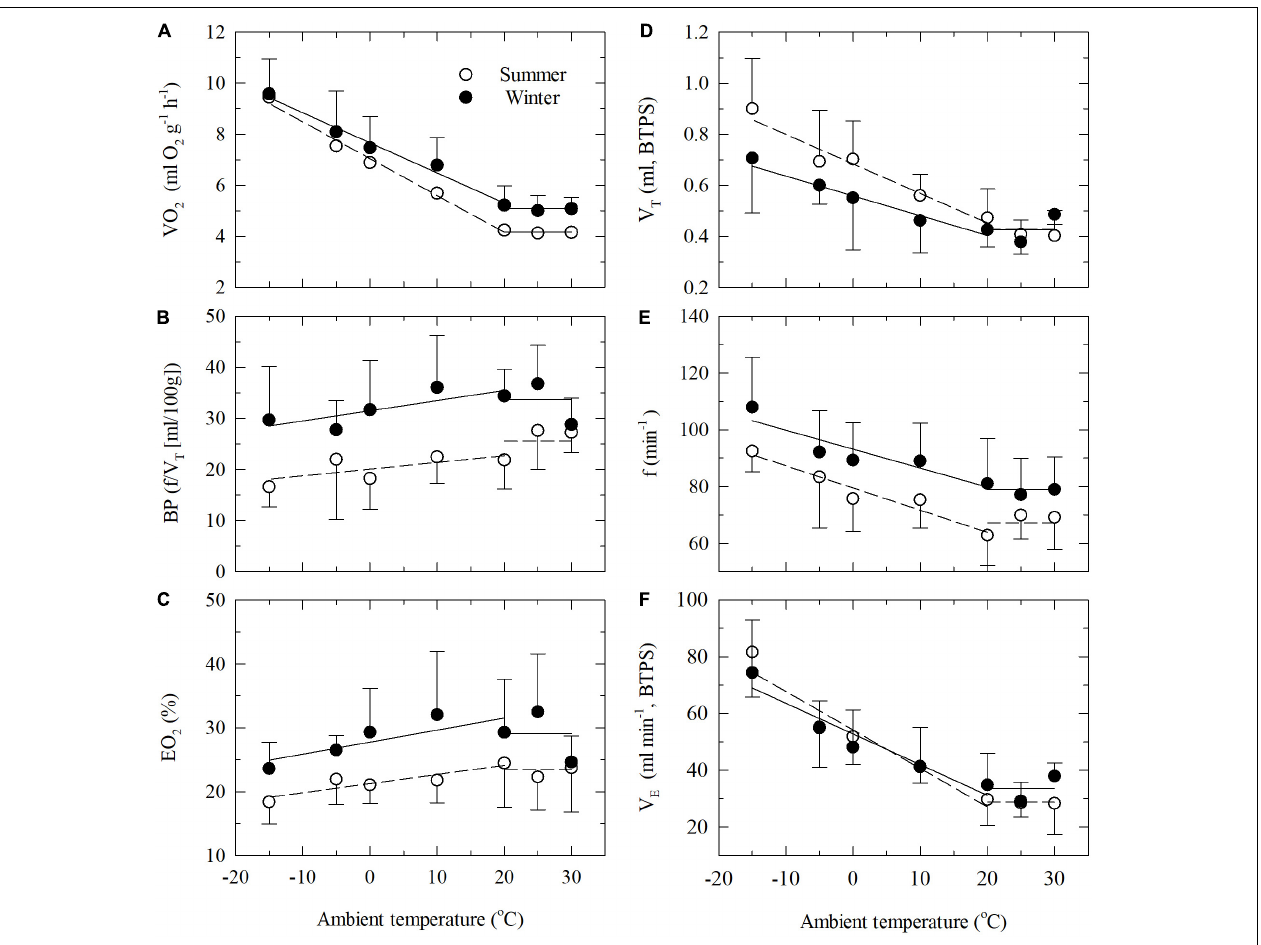
FIGURE 1 | Oxygen consumption (VO 2 , A ) and ventilatory parameters [ (B) breathing pattern BP; (C) lung oxygen extraction EO 2 ; (D) tidal volume VT; (E) respiratory frequency f; and (F) minute ventilation VE] as functions of ambient temperature in summer-acclimatized (open symbols) and winter-acclimatized (closed symbols) great tits. Shown are mean values with one SD at selected ambient temperature. Mean thermoneutral values and linear regression lines below thermoneutrality are shown for summer-acclimatized (stippled lines) and winter-acclimatized (solid lines)